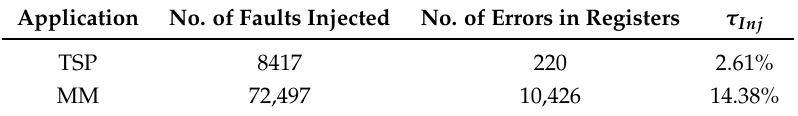
Table 2. Error-rate by fault-injection for Portable Operating System Interface uniX (POSIX) scenarios in